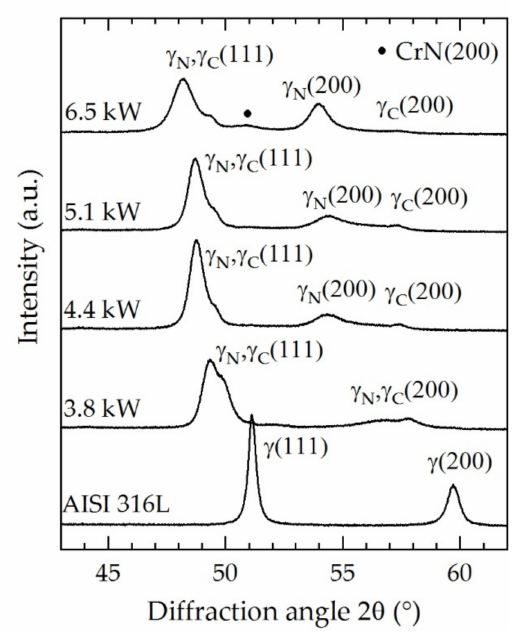
Figure 7. X-ray di ff raction profiles as function of the screen power for N 2 :H 2 = 1:1; T = 733 K; t = 5